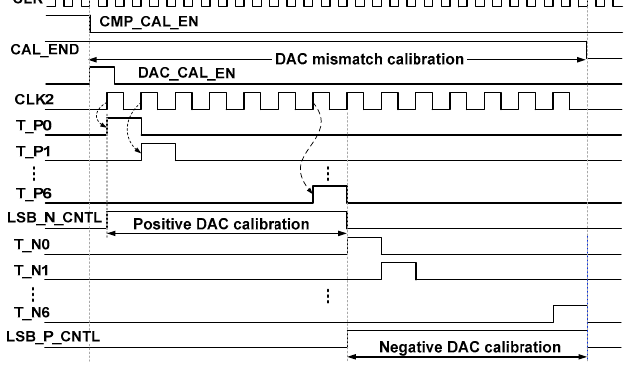
Figure 12. Timing waveform for DAC capacitor mismatch calibration.